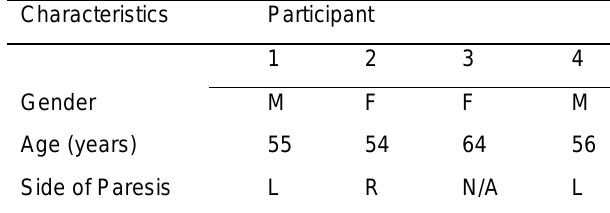
Table 1. Characteristics of the Participants